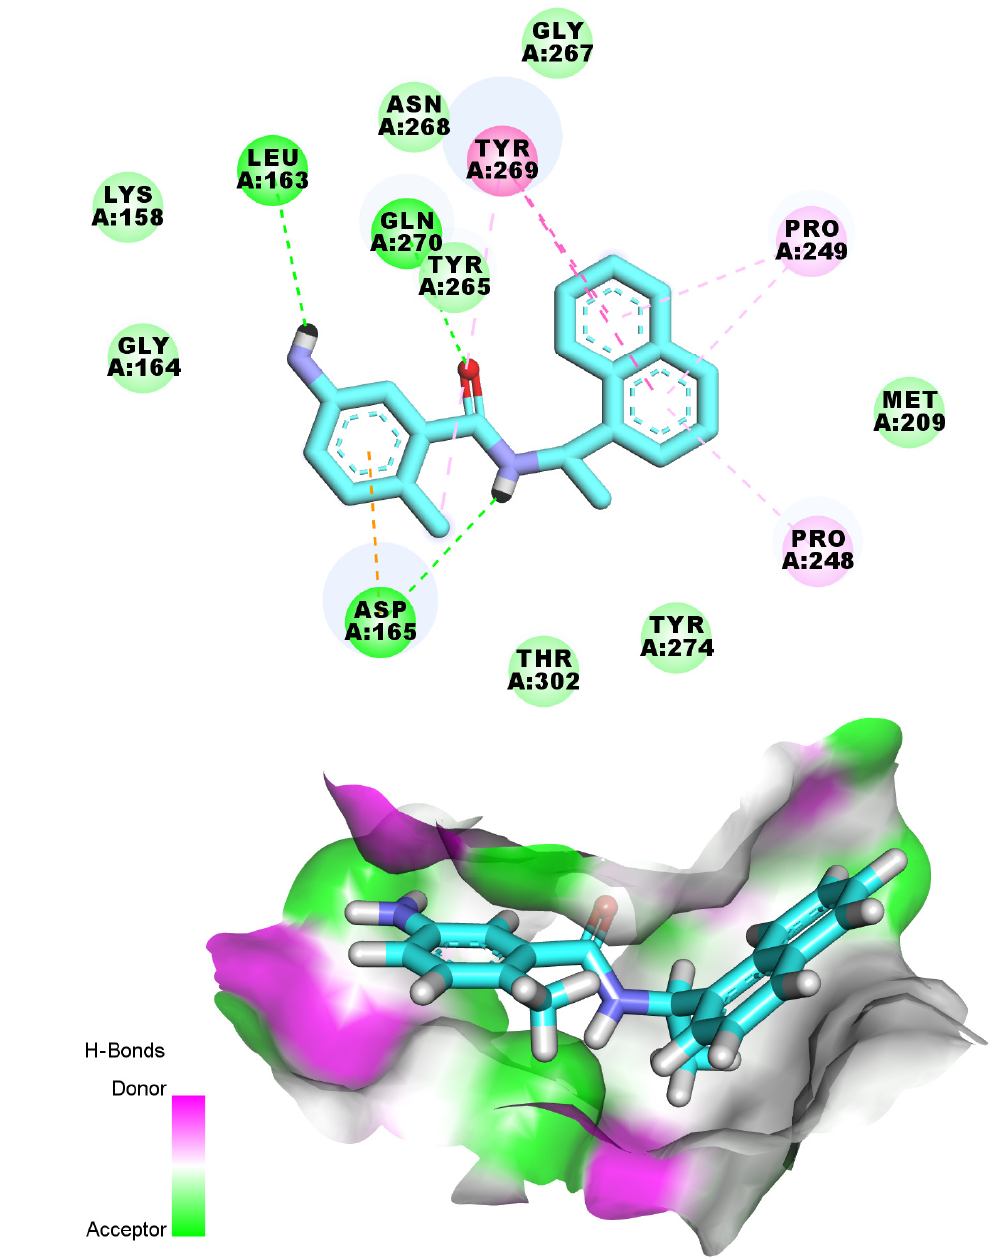
Figure 7. ( A ) 3D, ( B ) 2D and ( C ) Surface mapping of TTT inside the active site of PLP. The binding mode of 6-demethoxy-4‘-O-capillarsine ( 1 ) exhibited a binding free energy of -18.86 kcal/mol. The anisole moiety was directed into the first pocket of PLP forming one H- bond with the amino acid, Gln270, in addition to two hydrophobic interactions with the amino acids, Tyr269 and Asp165. The 5,7-dihydroxy-4H-chromen-4-one part occupied the second pocket of PLP forming a H- bond with the amino acid Pro249 besides two hydrophobic bonds with the amino acids Pro248 and Pro249 (Figure 8A–C). Tenuflorin C ( 2 ) bonded to PLP exhibiting a binding energy of − 18.37 kcal/mol. The 2-methoxyphenol part was directed into the first pocket of PLP with two H-bonds with the amino acids Gln270 and Leu163. Additionally, the same moiety was engaged hydrophobically in two interactions with the amino acids Tyr269 and Asp165. Further, the 5,7-dihydroxy-4H-chromen-4-one part occupied the second pocket of PLP forming two